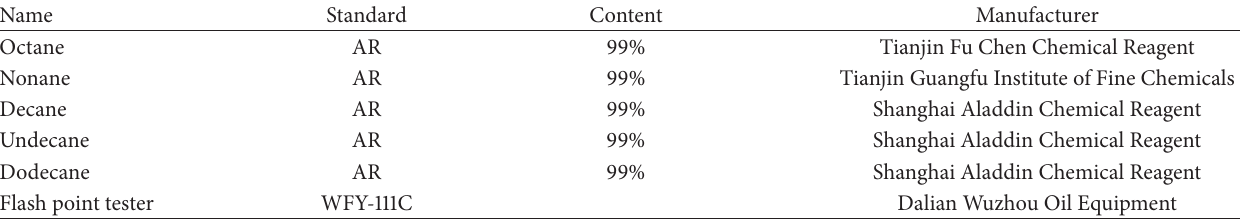
Table 1: Reagents and instruments.